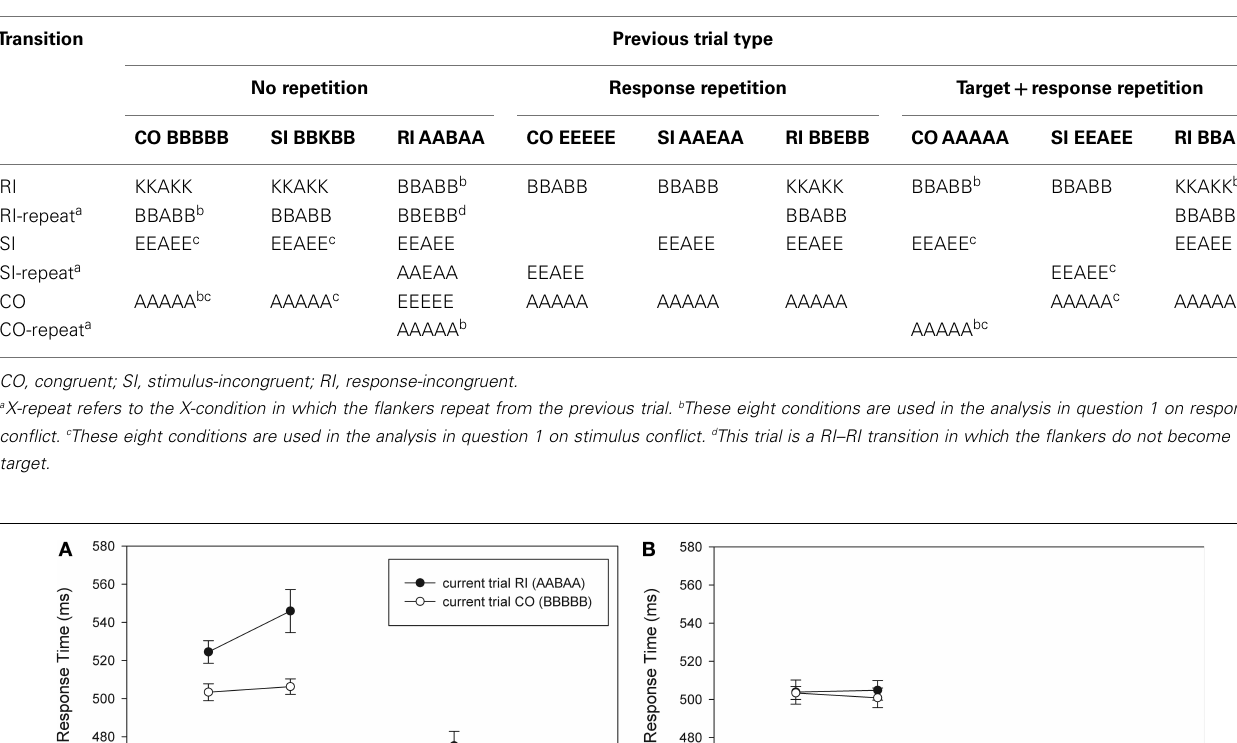
Table 2 | Examples of stimuli used in Experiment 1 by condition.